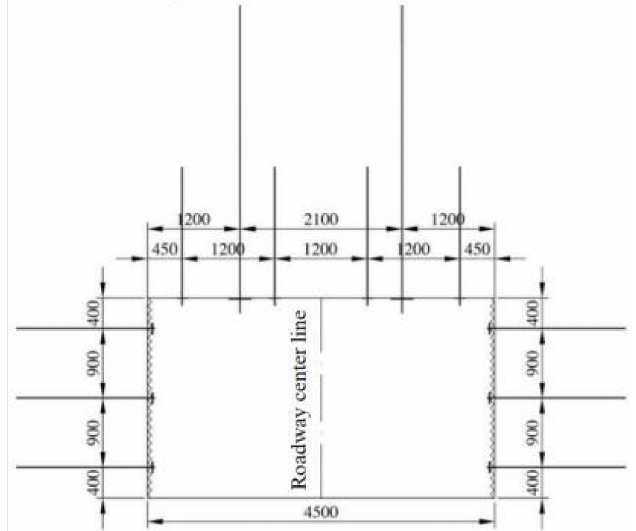
Figure 16. Roadway support arrangement.